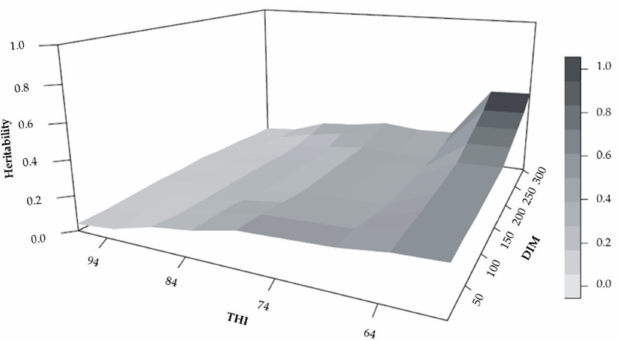
Figure 4. Estimated heritability for test-day milk yield, TDMY, according to temperature–humidity index (THI) and days in milk (DIM) according to model 4 (M4) using Legendre